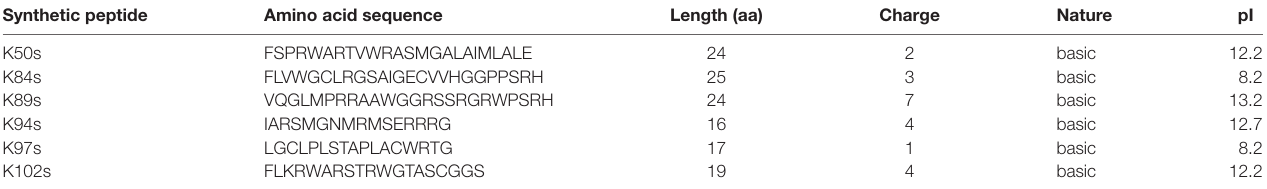
TABLE 4 | Amino acid sequences and physicochemical properties of chemically synthesized short peptides. Synthetic peptide Amino acid sequence